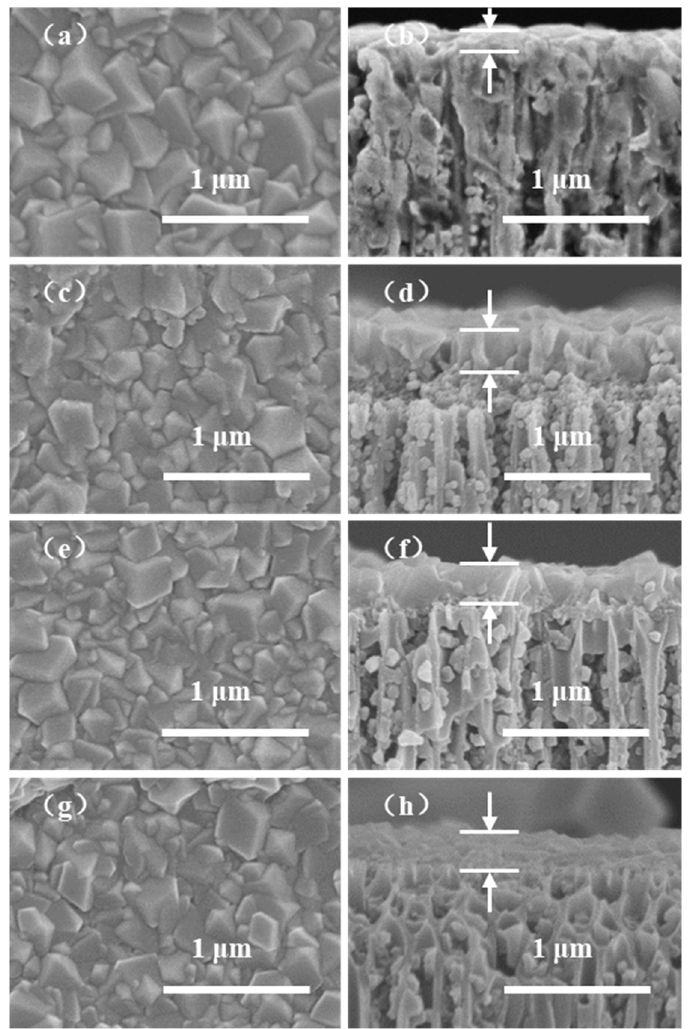
Figure 8. SEM images of ZIF-8/AAO membranes deposited for 60 min under different deposition currents, in which the left images show the surface morphology and the right images show the cross-section morphology: ( a , b ) 0.1625 mA/cm 2 , ( c , d ) 0.325 mA/cm 2 , ( e , f ) 0.65 mA/cm 2 , ( g , h ) 1.3 mA/cm 2 .